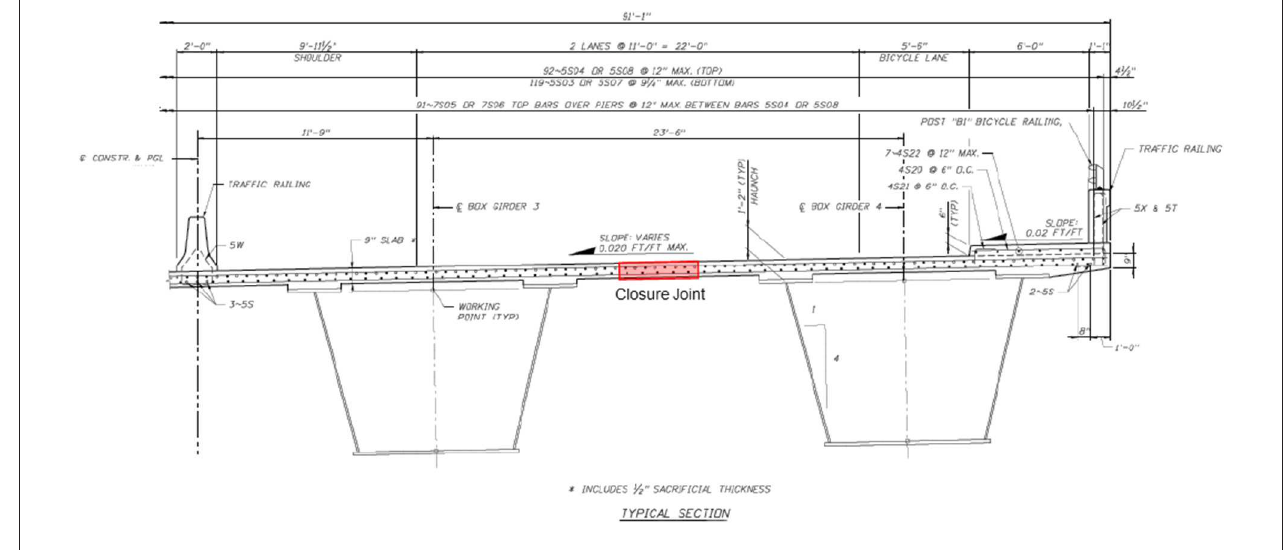
FIGURE 7 | Superstructure cross-section.